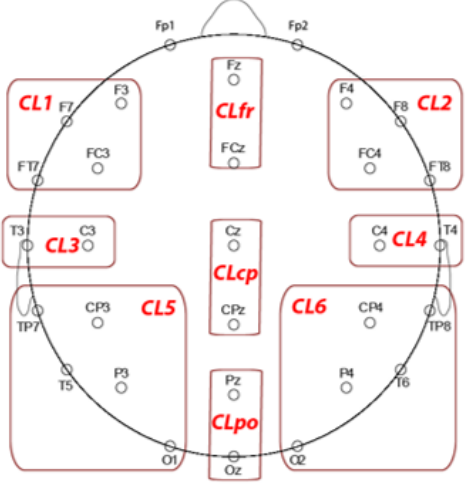
Figure 2. EEG sites grouped in the clusters used to perform the statistical analysis on N1, P2, and P3 components.